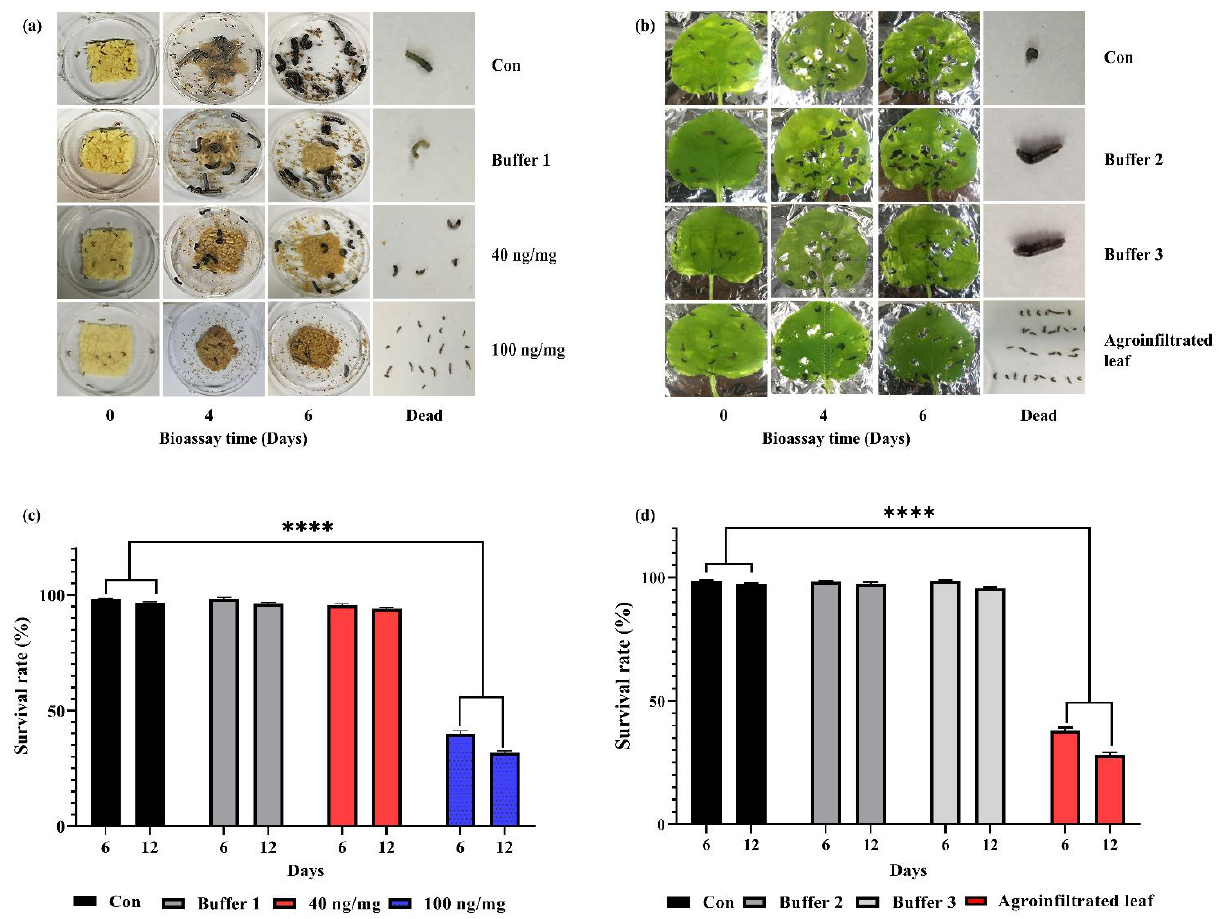
Figure 5. Insecticidal activity for S. litura using the recombinant Vip3Aa-treated-artificial diet and the Vip3Aa-agroinfiltrated plant leaf. ( a ) The recombinant Vip3Aa protein immersion artificial diet and ( b ) agroinfiltrated plant leaf were used for insect bioassay as feed for S. litura . The experiment was repeated five times. ( c , d ) Impact of Vip3Aa on the survival of S. litura on the artificial diet ( c ) and agroinfiltrated leaf-feeding ( d ) for 6 and 12 d. Number, feeding time (day); dead, dead insect; Con, mock; Buffer 1, PBS buffer; LC, Vip3Aa protein (40 ng/mg); HC, Vip3Aa protein (100 ng/mg); Buffer 2, infiltration buffer; Buffer 3, vector; leaf: Vip3Aa-agroinfiltrated leaf. Values are expressed as the means ± SEM. ****, p < 0.0001compared with the control.